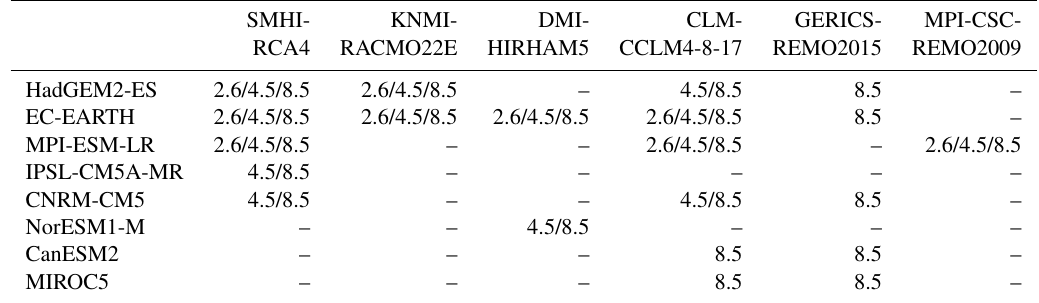
Table 3. Modeling matrix of driving global models – rows – and the respective regional models – columns – used in this study. The numbers indicate the respective RCP scenarios covered by each GCM–RCM